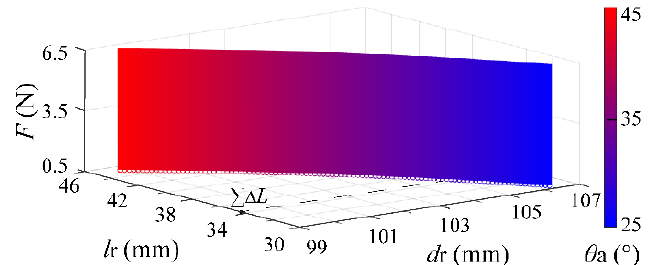
Figure 5. Relationship between stretching force and assembly angle.